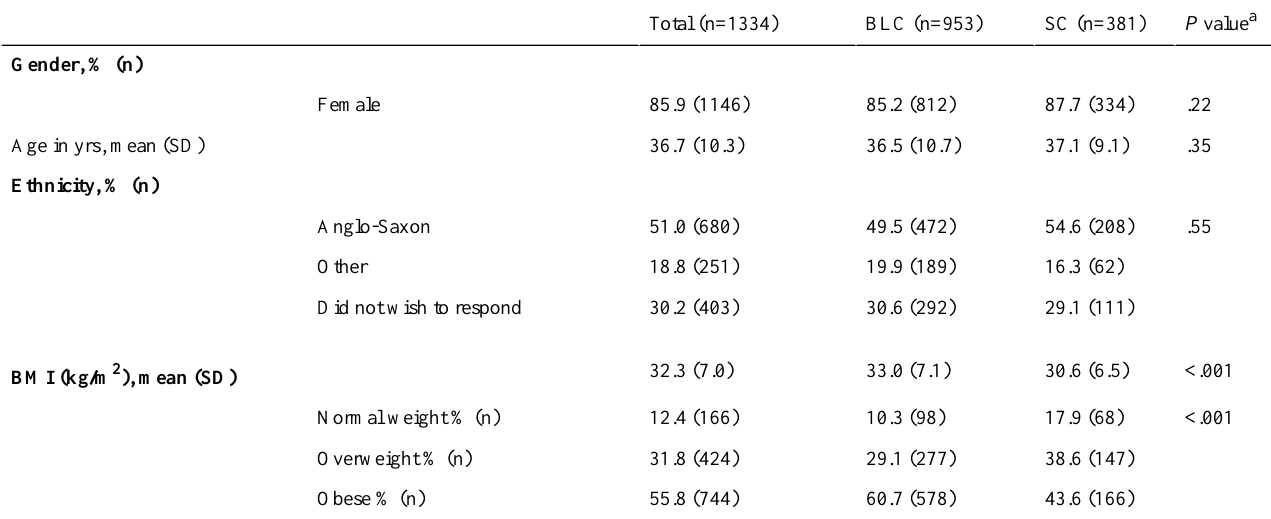
Table 2. Baseline characteristics of participants who enrolled in the BLC or the SC programs.